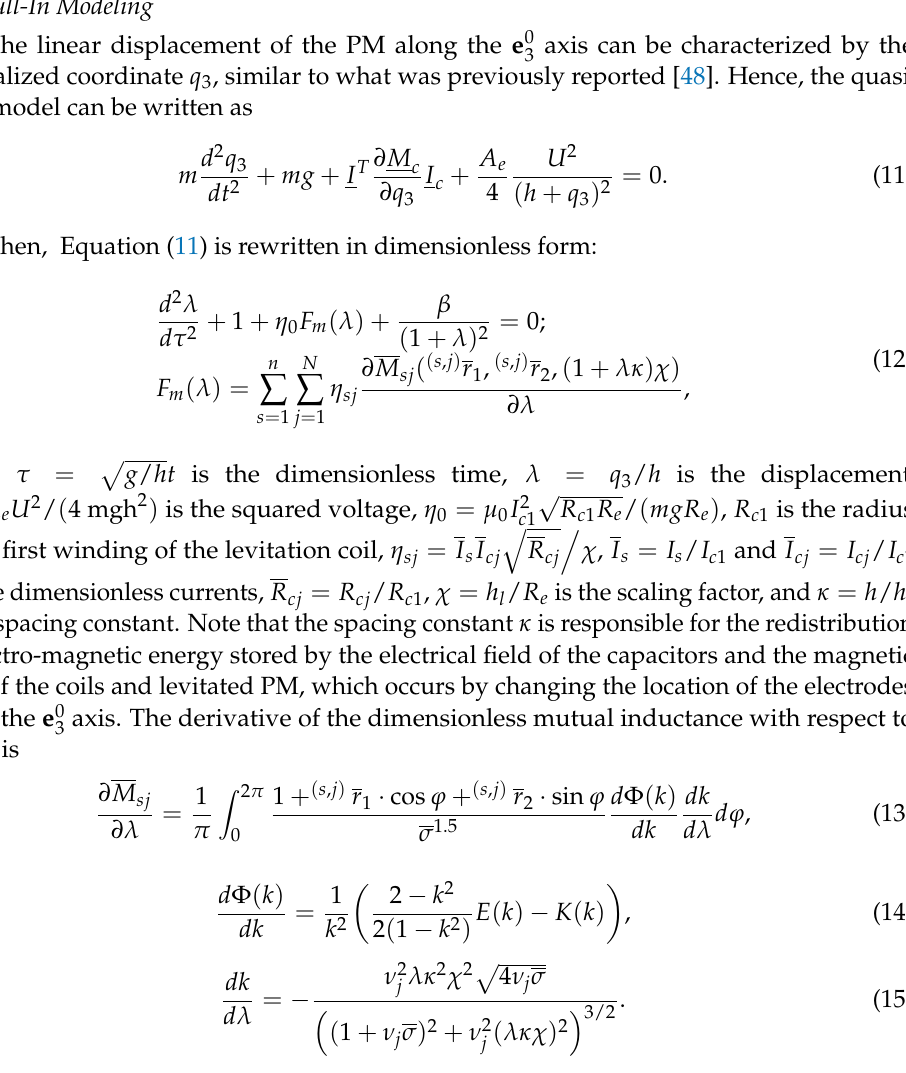
Figure 6. The results of the eddy current calculation: ( A ) the distribution of the eddy current in mesh circular elements; ( B ) the distribution of the magnitudes of eddy current with respect to rhw unit vectors of e 1 and e 1 of the base e 1 2 1